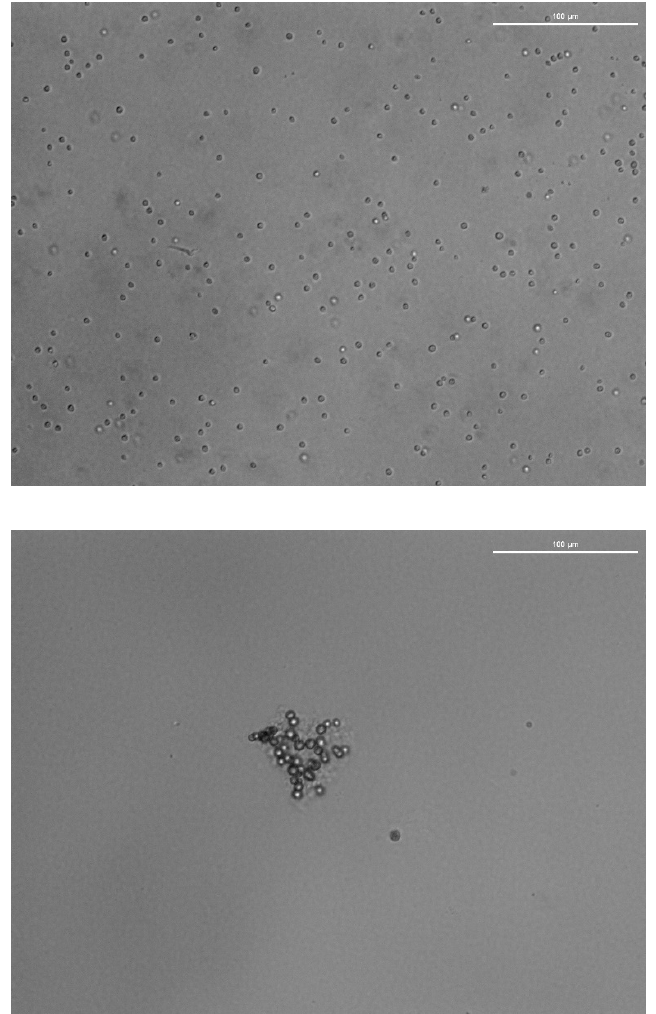
Figure 1. Comparison of a normal culture of C. vulgaris , with single, isolate, suspended cells (upper picture) and a culture exposed to low concentrations of Cu (lower picture) showing the mucilaginous matrix with cells embedded. In both cases, C. vulgaris cells keep their characteristic “O” shape.